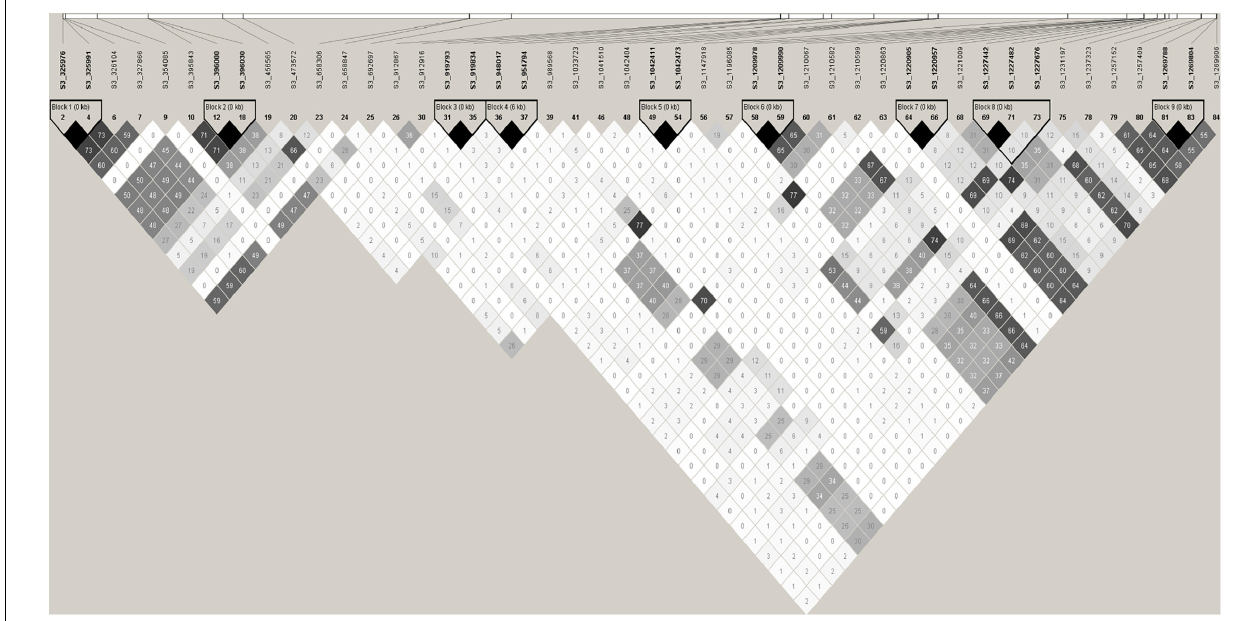
FIGURE 6 | Haploview plot of pairwise linkage disequilibrium (LD) between SNPs associated with race 13 of P. effusa resistance region (0.30–1.30 Mb). LD is measured as r 2 with maximum LD of colored as black and the minimum LD in shades of gray to white. Potential candidate genes close to the associated SNPs are listed in Table 2